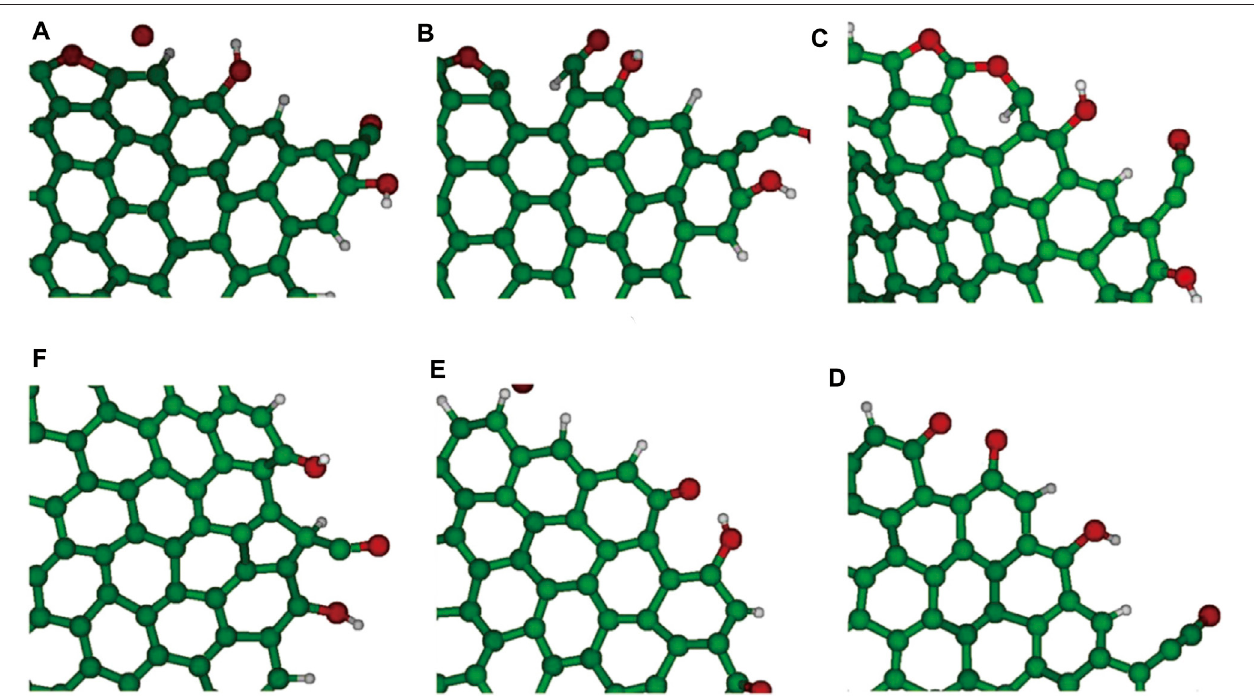
FIGURE11| Conversion ofsix-membered ring into fi ve- and seven-membered rings demonstratedvia ReaxFF MD combustion at 3000 K (for interpretation ofthe references to color in this fi gure legend, the reader is referred to the web version of this article) (from Castro-Marcano et al., 2012).